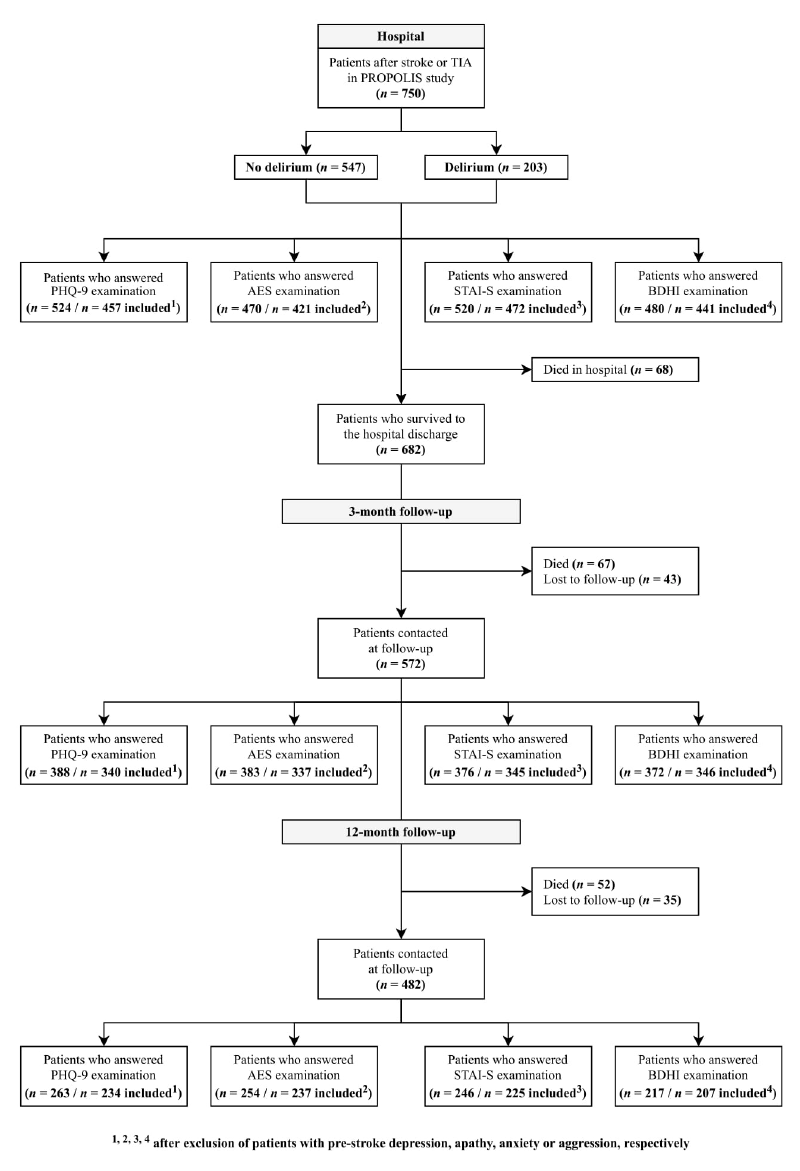
Figure 1. Study flowchart.